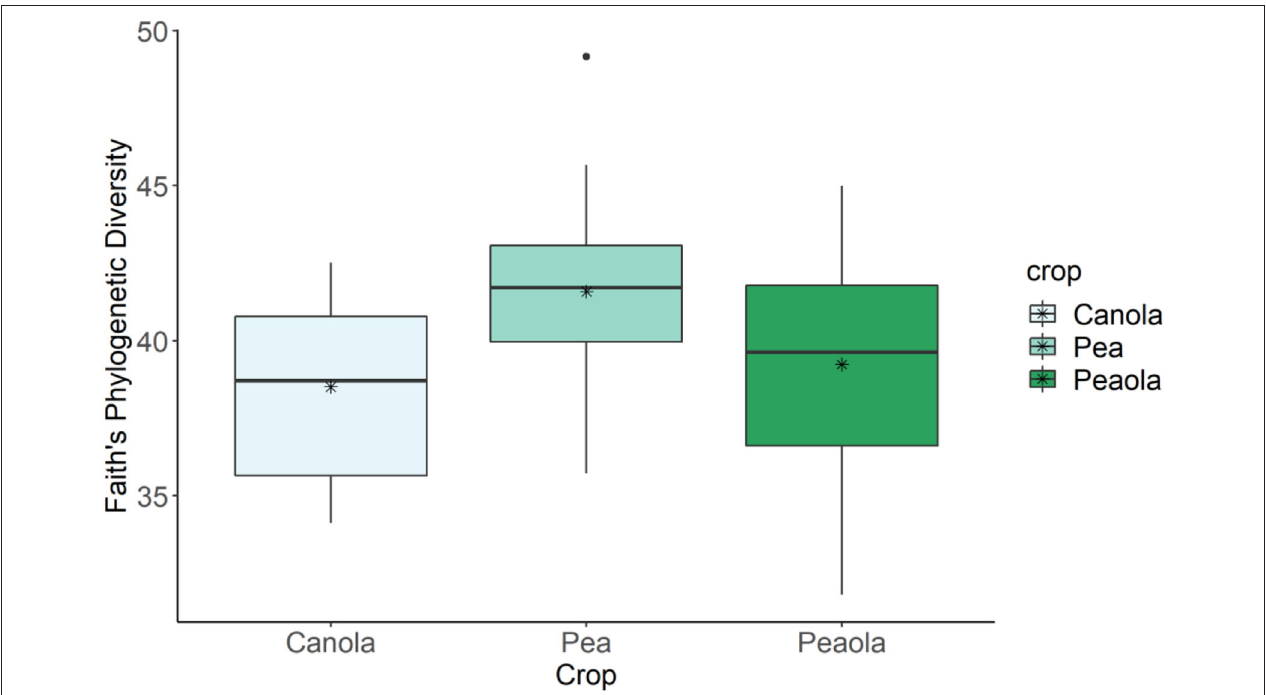
FIGURE 6 | Results of Faith’s Phylogenetic Diversity index for canola, pea, and peaola soils. The microbial communities in the monoculture pea soil are trending toward being richer than the monoculture canola soil as determined by the Faith’s Phylogenetic Diversity index (Kruskal–Wallis Test, n1 = 12, n2 = 12, H = 5.60, P = 0.0537). No significant difference or trend was found in the community richness of the peaola soil and pea monoculture soil (Kruskal–Wallis Test, n1 = 12, n2 = 12, H = 1.47, P = 0.3380) and canola monoculture soil (Kruskal–Wallis Test, n1 = 12, n2 = 12, H = 0.653, P = 0.4189) as determined by the Faith’s Phylogenetic Diversity index. * is the